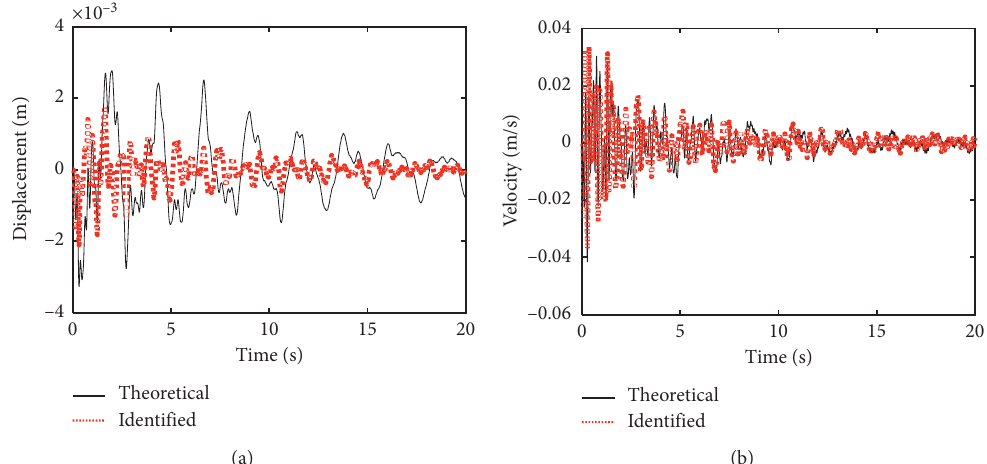
Figure 10: (a) Theoretic and determined vertical shift at Node 7 with smaller R